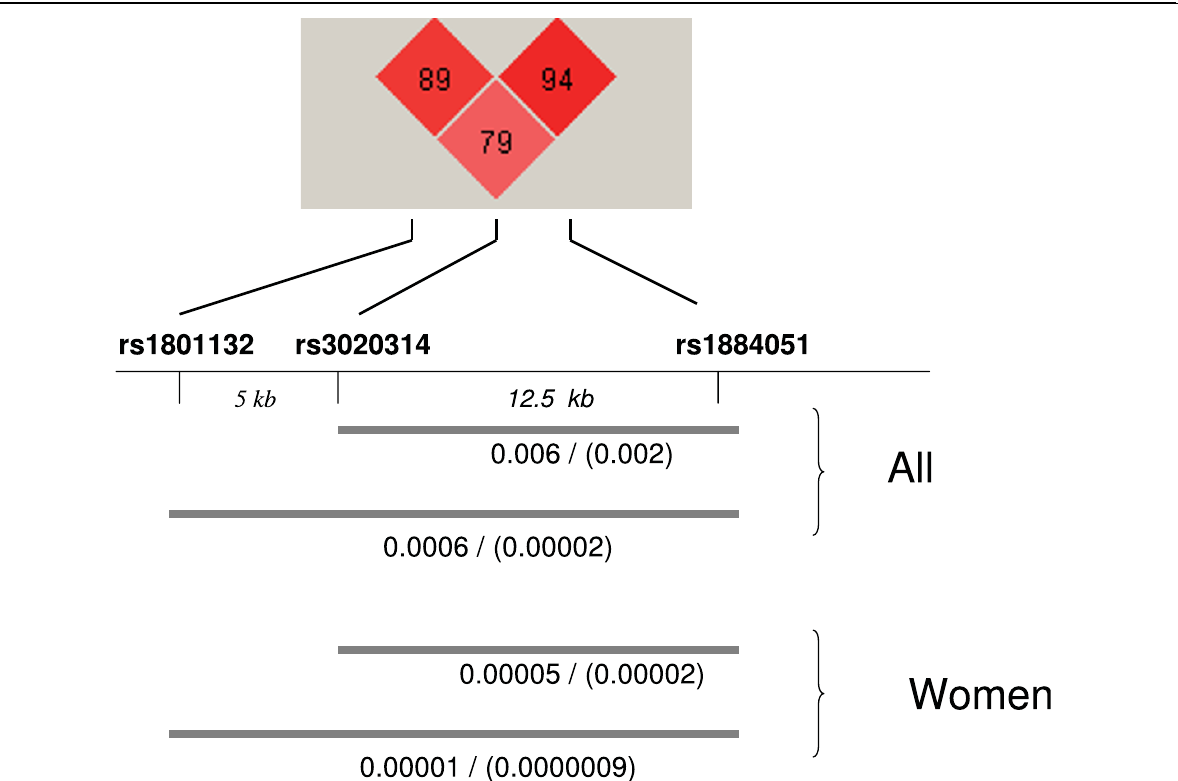
Figure 1 ESR1 haplotypes and hip fractures . Diagram showing the association of 2-SNP (rs3020314 and rs1884051) and 3-SNP (rs1801132, rs3020314 and rs1884051) haplotypes with hip fractures in the whole group of men and women combined and in the female group. The numbers represent the p-values of the omnibus c 2 test including all haplotypes and the result for the individual haplotype showing the